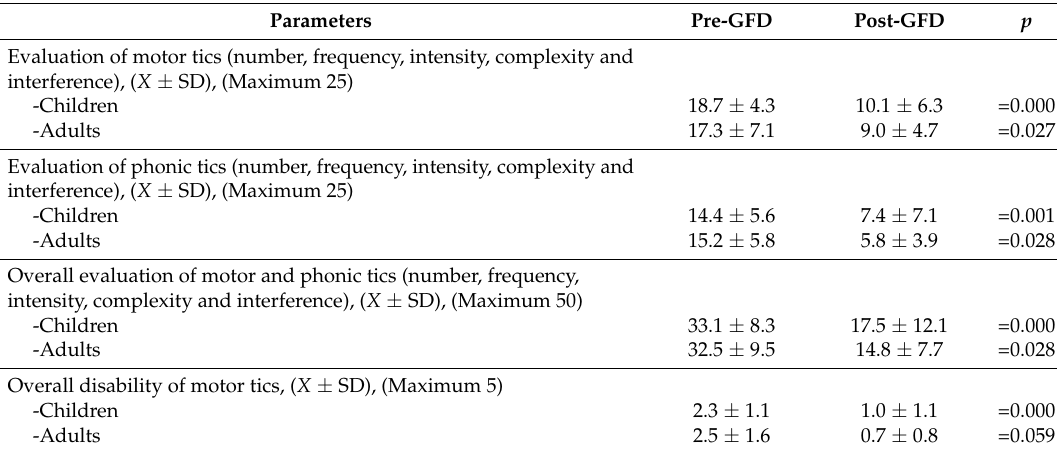
Table 4. Evolution after 1 year of a GFD of the various components of motor and phonic tics, obsessions and